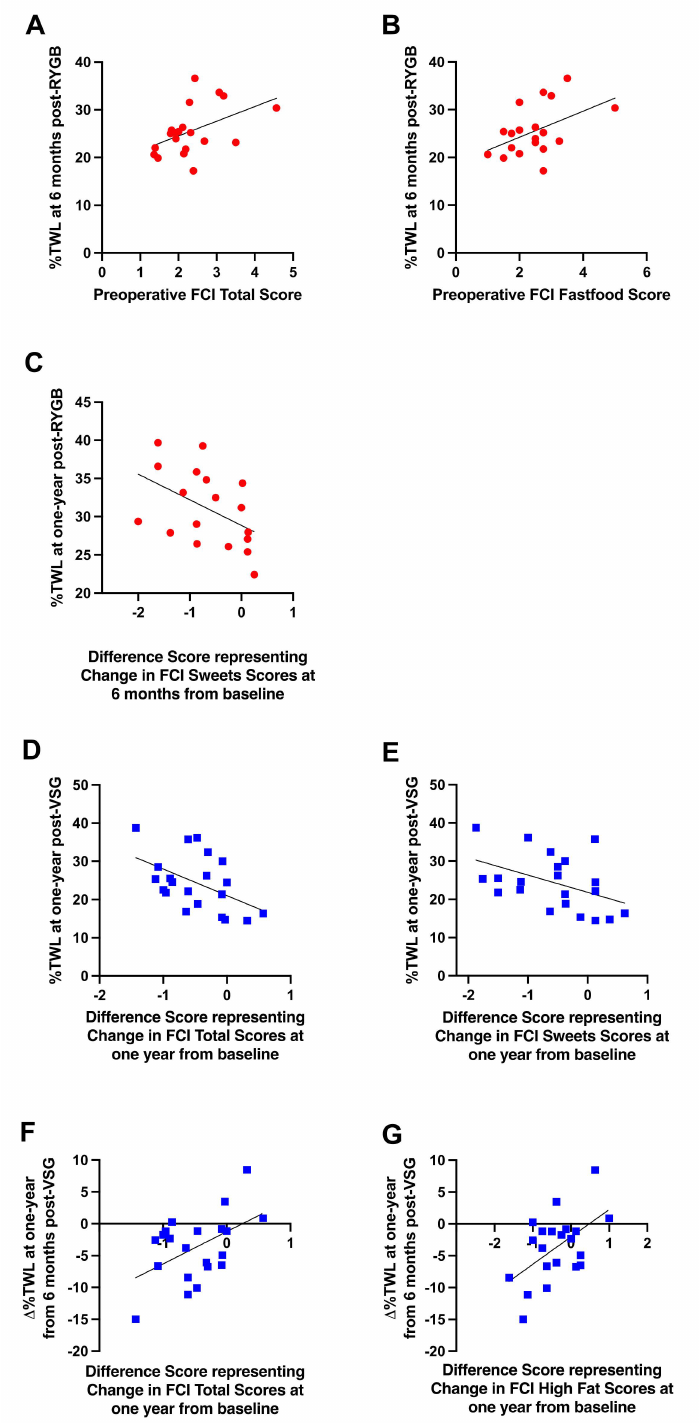
Figure 8. Significant relationships between ( A ) preoperative self-reported total craving scores and %TWL at six months post-RYGB (red circles), ( B ) preoperative self-reported cravings for fast food and %TWL at six months post-RYGB (red circles), ( C ) changes in self-reported sweet cravings at six months from baseline and %TWL at one year post-RYGB (red circles), ( D ) changes in self-reported total food cravings at one year from baseline and %TWL at one year post-VSG (blue squares), ( E ) changes in self-reported sweet cravings at one year from baseline and %TWL at one year post-VSG (blue squares), ( F ) changes in self-reported total food cravings at one year from baseline and ∆ %TWL from six months to one year post-VSG (blue squares), ( G ) changes in self-reported fat cravings at one year from baseline and ∆ %TWL from six months to one year post-VSG (blue squares). Line of best fit represents significant